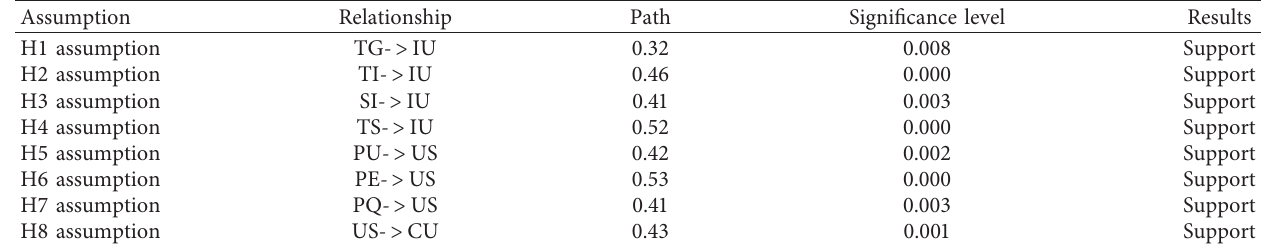
Table 7: Path analysis and verification results of the structural